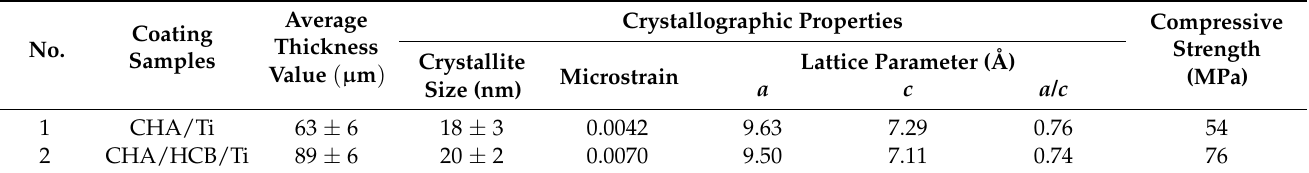
Table 1. Physicochemical and mechanical properties of CHA/Ti 30 min and CHA/HCB/Ti 30 min samples